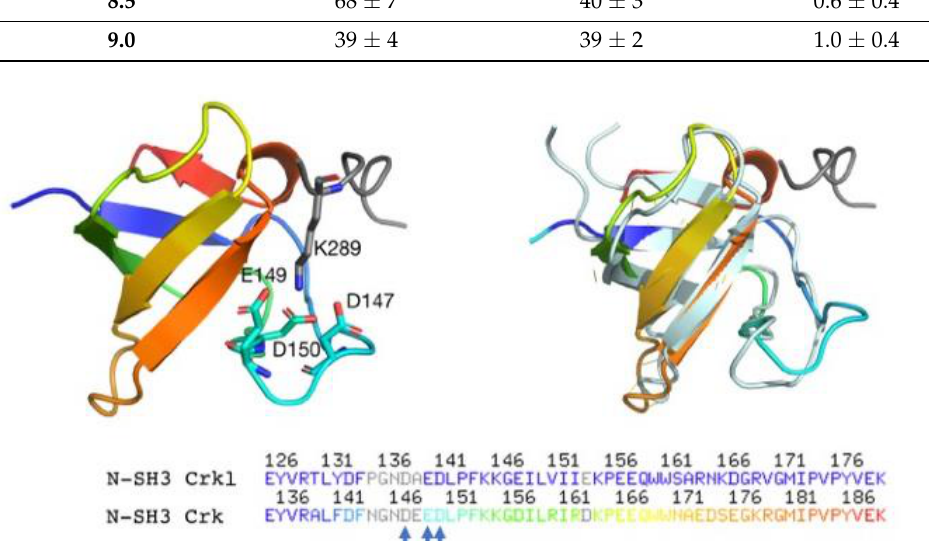
Figure 3. Left : three-dimensional structure of the N-SH3 domain of Crk (rainbow colors) in complex with C3G (gray) (PDB: 1cka). Acidic residues D147, E149 and D150 together with basic residue K289 of C3G are highlighted in sticks. K289 is coordinated by the three negatively charged residues in the binding pocket of Crk, which are conserved in Crkl; right and bottom : structural and sequence alignment of the N-SH3 domain of Crk (rainbow colors) with the N-SH3 domain of Crkl (light blue). D147, E149 and D150 residues of Crk are highlighted with blue arrows.